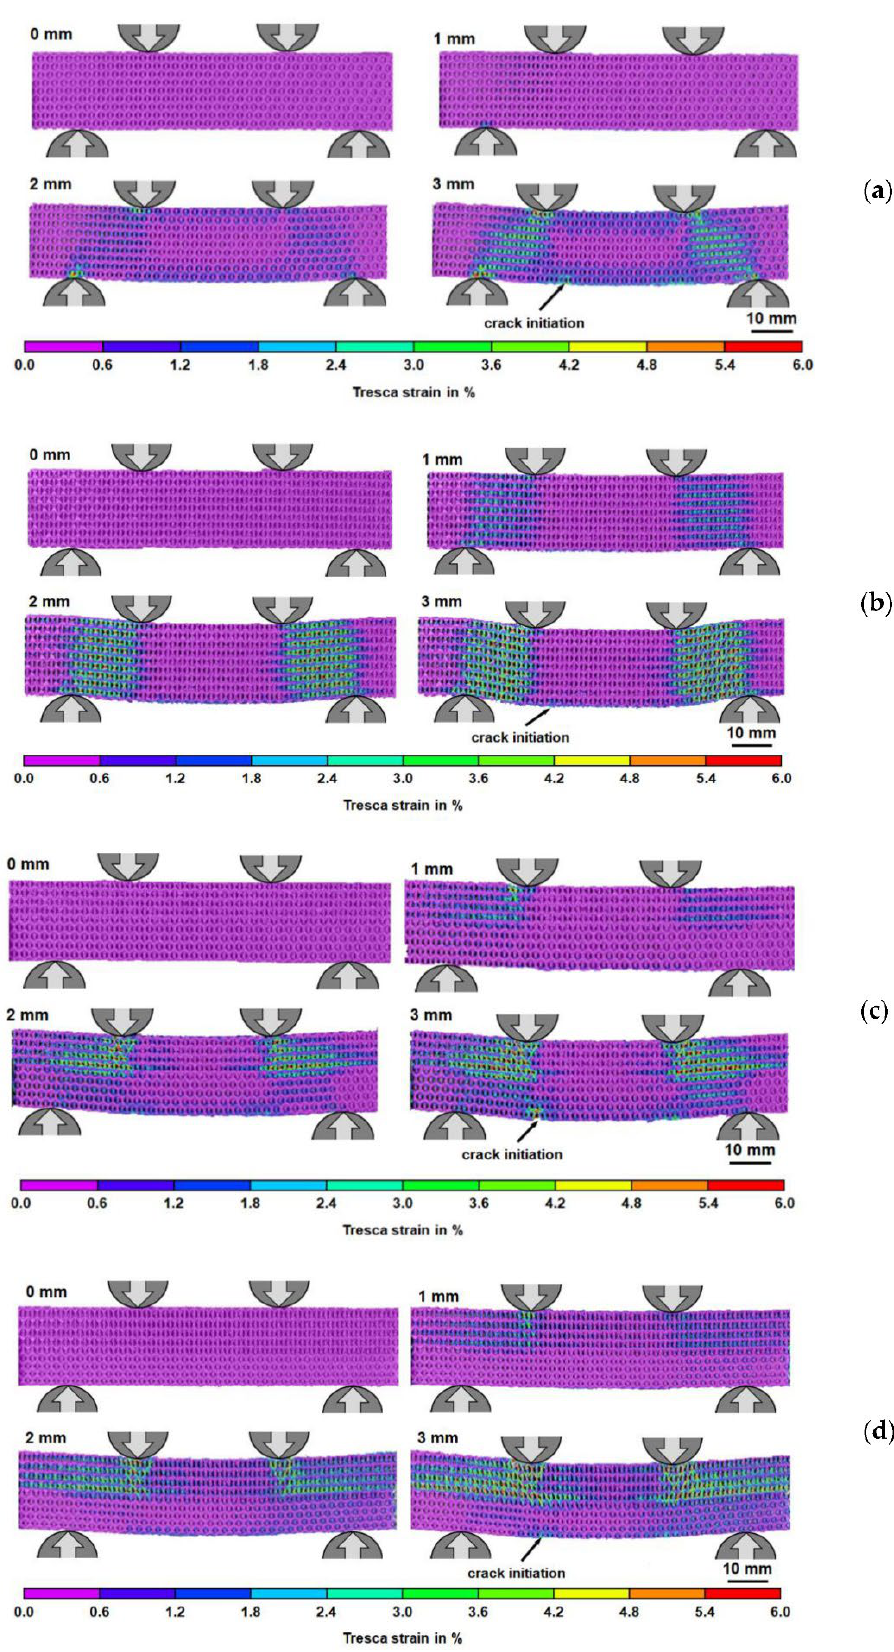
Figure 13. The development of the first cracks in the ( a ) PPR, ( b ) NPR, ( c ) HPR, and ( d ) FGHPR lattice structures under FPB loading.